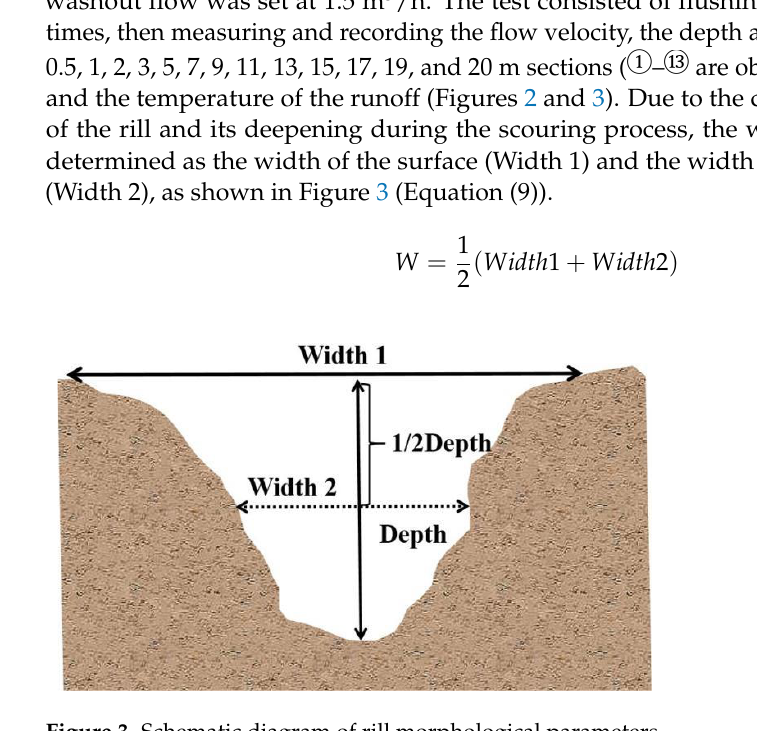
Figure 2. Sketch of the simulated scouring experiment with two plots (note that ① – ⑬ are the observation cross-sections).